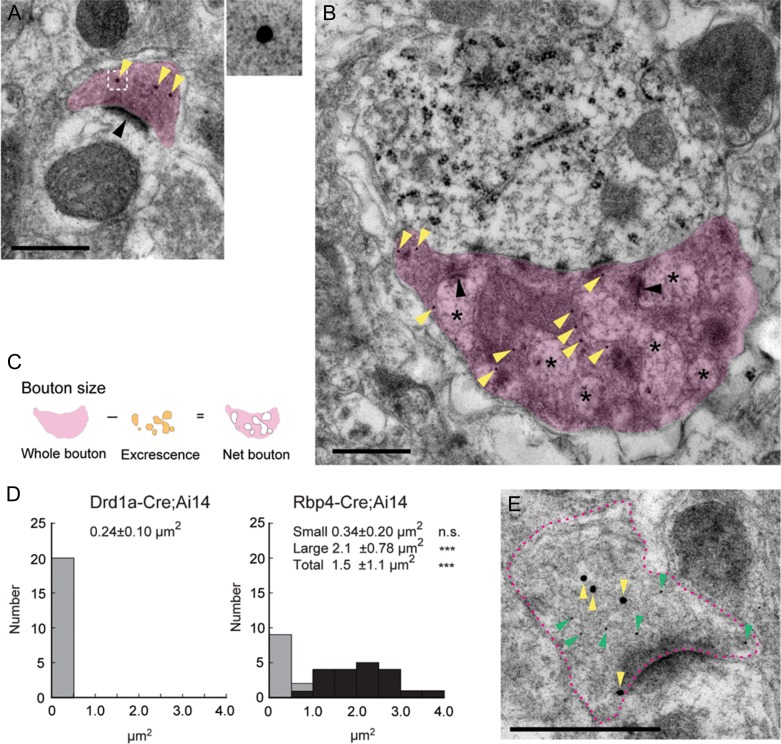

Ultrastructural comparisons of Drd1a-Cre::tdTom+ and Rbp4-Cre::tdTom+ boutons in Po. (A,B) Electron micrographs of Drd1a-Cre::tdTom+ (A) and Rbp4-Cre::tdTom+ (B) boutons labeled with postembedding immunogold against tdTomato. (A) A typical example of a Drd1a-Cre::tdTom+ bouton (magenta) that has a single asymmetric synapse (black arrowhead). Yellow arrowheads pointing to gold-particles labeling tdTomato. The boxed region in the left image is given at higher magnification on the top right to show a gold particle. (B) A typical example of a Rbp4-Cre::tdTom+ large bouton (magenta) that has multiple synapses (black arrowheads) and contains dendritic excrescences (asterisks) inside. (C,D) Quantitative analysis of the size of Drd1a-Cre::tdTom+ and Rbp4-Cre::tdTom+ boutons in Po. (C) For Rbp4-Cre::tdTom+ large boutons, the net area of the boutons excluding excrescences was measured. (D) Size distribution histogram of Drd1a-Cre::tdTom+ (left) and Rbp4-Cre;tdTom+ (right) boutons in single sections. The size of Drd1a-Cre::tdTom+ boutons is significantly smaller than that of the Rbp4-Cre::tdTom+ large boutons (right, black bars), but not different from that of the Rbp4-Cre::tdTom+ small boutons (right, gray bars). Dunn’s multiple comparison test. ***P < 0.001 (E) A Drd1a-Cre::tdTom+ axon that expresses VGluT1 in its bouton. Magenta dotted line outlines the bouton of a Drd1a-Cre::tdTom+ axon. Yellow and green arrowheads indicate 20 nm and 10 nm immunogold particles, which label tdTomato and VGluT1, respectively. Scale bars, 500 nm.